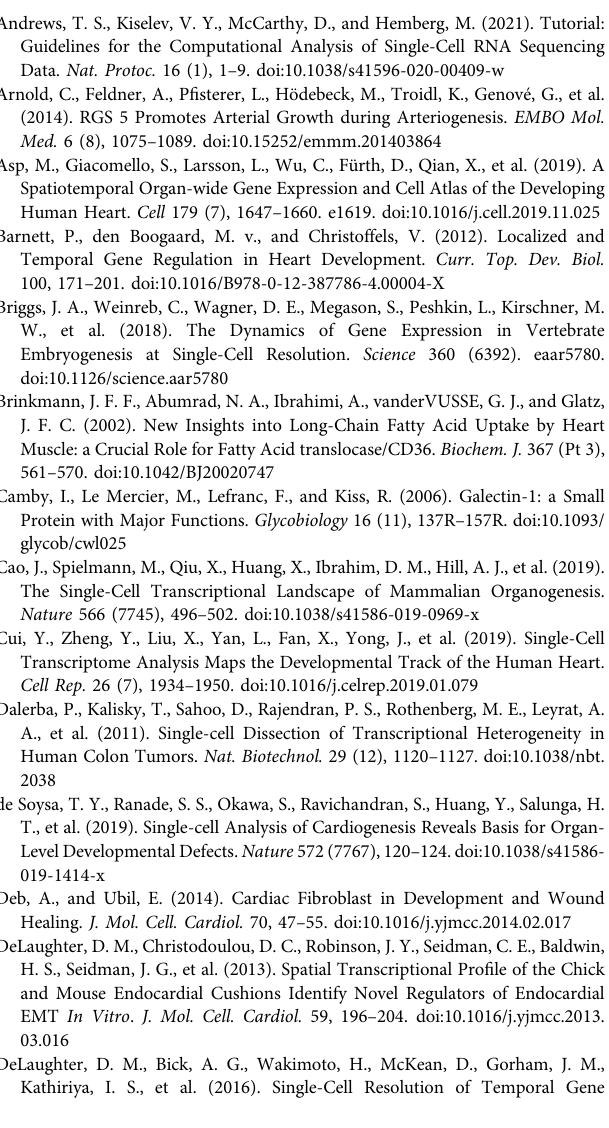
Supplementary Figure S4 | Construction of pseudotemporal trajectory of human and mouse endothelial cells/ fi broblasts. (A) Heatmap showing the molecular characteristics of each endothelial cell/ fi broblast subpopulation (human: H, left; mouse: M, right). (B) Pseudotemporal trajectory of EC/FB subpopulations constructed by Monocle2 colored by developmental stage (human: H, top; mouse: M, bottom). (C) Violin plots showing the expression of CD36, FABP4 in EC/FB subclusters (human: left; mouse: right). Supplementary Table S1 | Differentially expressed genes of different cell types in human and